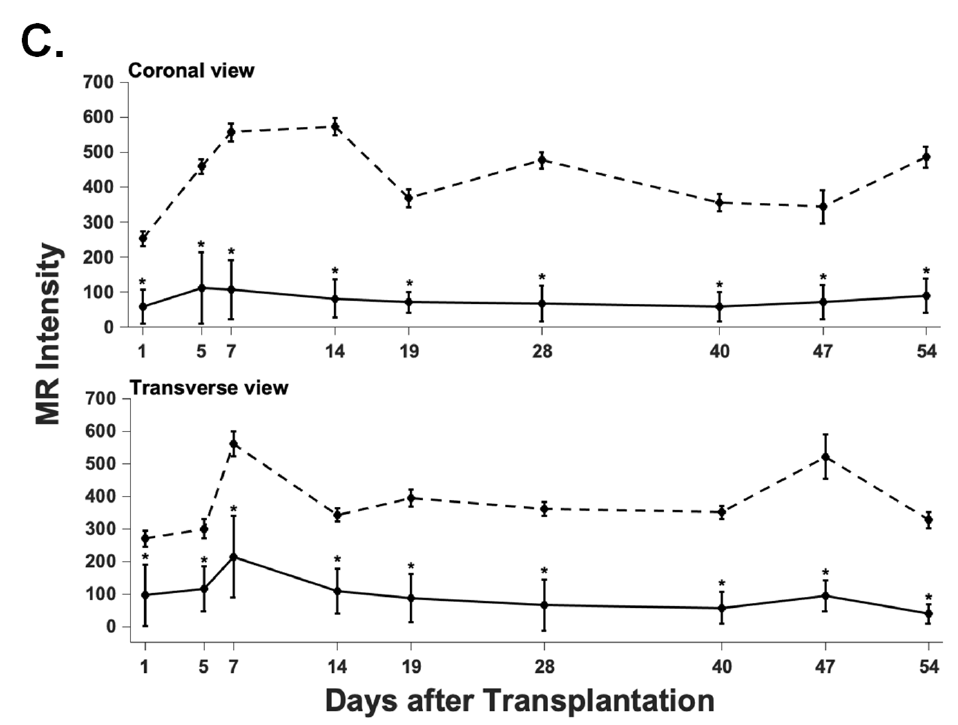
Figure 4. In vivo magnetic resonance (MR) images of a MnMEIO-Ex4-labeled NPCCs graft followed- up for 54 days posttransplantation. Two thousand MnMEIO-Ex4-labeled NPCCs were transplanted under the left kidney capsule of a nude mouse. The recipient was scanned by a 7.0 T MRI machine with coronal ( A ) and transverse ( B ) sections. The graft was indicated by arrows. ( C ) The time course of the MR signal intensity of the graft on left kidney (solid line) ae mirror area on the contralateral kidney (dash line) in the mouse. * p < 0.001.